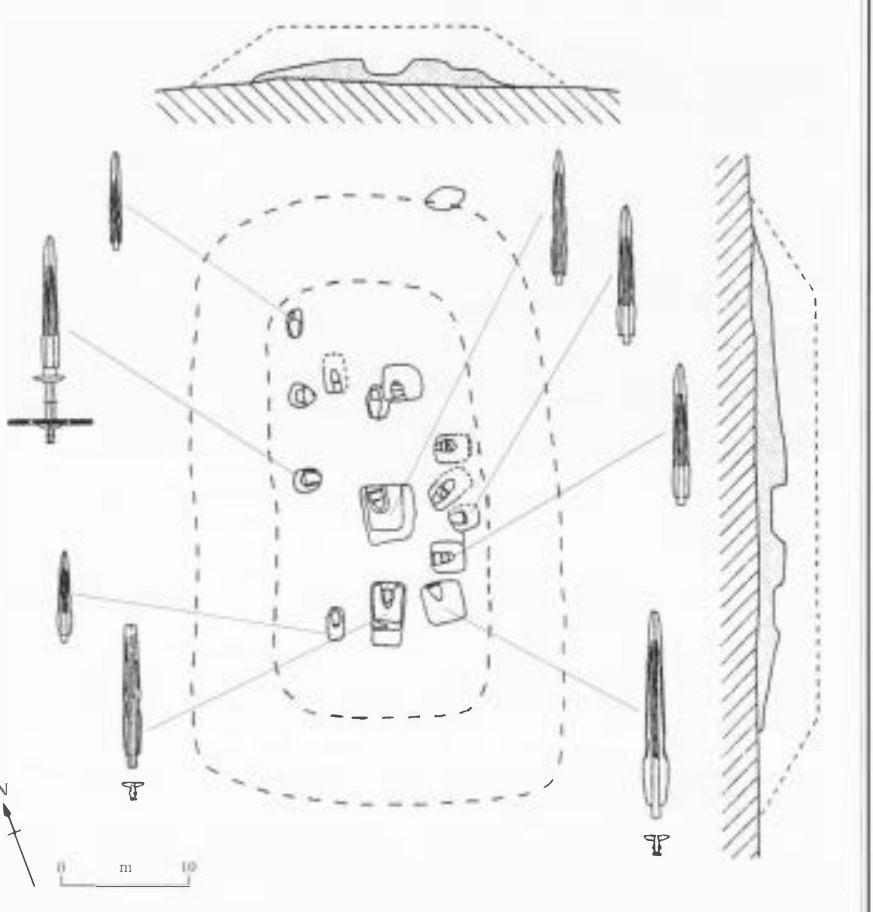
Figure 6 Plan of the cemetery at Yoshinogari showing the location of successive jar bur­ ials and the eight bronze daggers found in them (see Fig. 5). The dashed lines indicate the original area] extent and height of the mound (see Fig.